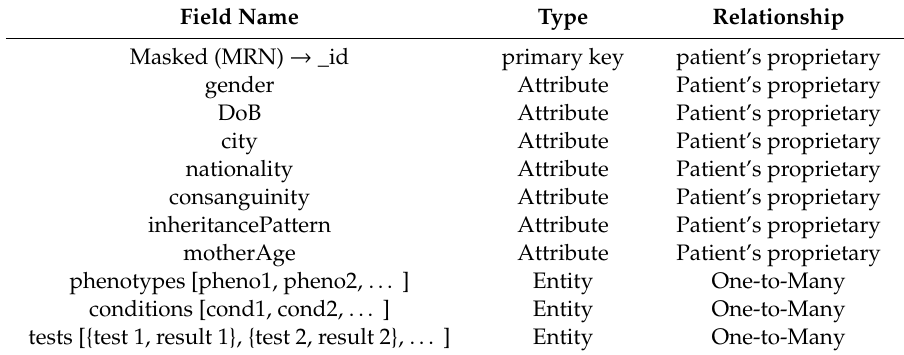
Table 1. List of fields extracted from the G3DMS (genetic disorders diagnosis data management